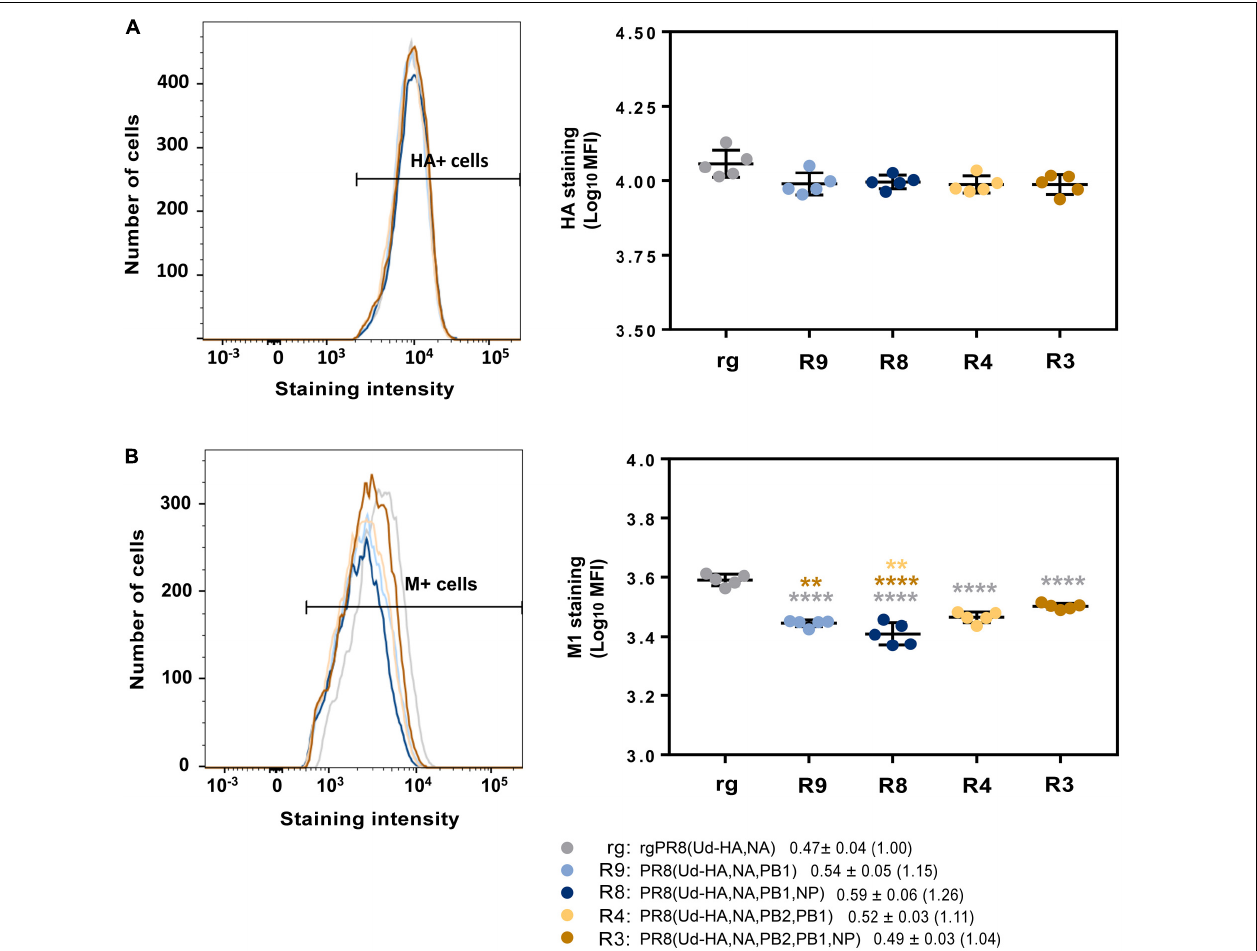
FIGURE 6 | Flow cytometric analysis of Udorn HA and PR8 M1 protein production in infected cells. MDCK cells (1 × 10 6 ) were infected with different viruses at an MOI of 3 and protein production assessed 6 h after a 1 h virus absorption period. Cells were stained with either (A) anti-Udorn HA (AF647) or (B) anti-M1 (MCA401) followed by a secondary antibody coupled to a fluorescent dye for the detection of proteins. Left panels show example flow cytometry histograms of stained cells with the fluorescence range for positive cells indicated; right panels show individual data for the mean fluorescent intensity (MFI) from five replicate cultures and is representative of three experiments. Statistical significance was determined by one-way ANOVA with Sidak’s multiple comparison test (** p < 0.01, **** p < 0.0001) for (A) ( F 4 , 20 = 3.24) and (B) ( F 4 , 20 = 45.59). Grey, brown and yellow asterisks indicate comparison of viruses with rgPR8(Ud-HA,NA), PR8(Ud-HA,NA,PB2,PB1,NP), and PR8(Ud-HA,NA,PB2,PB1) respectively. Values in the key represent the mean and SD of the ratios of HA staining to M1 staining for each individual allantoic fluid within each group with the fold difference compared to rgPR8(Ud-HA,NA) in